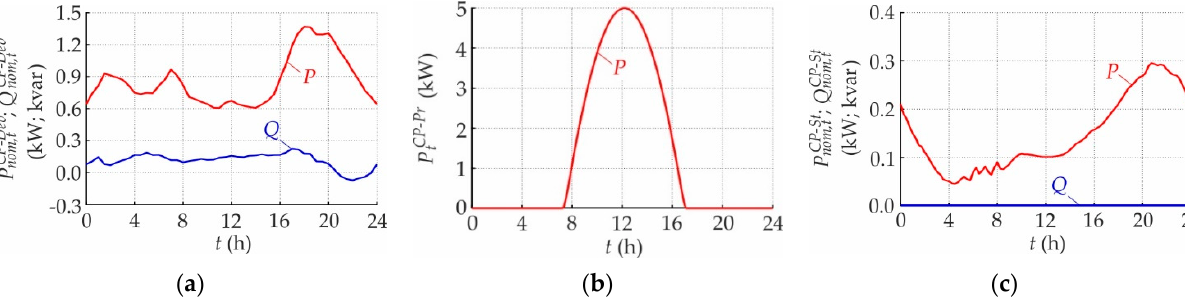
Figure 5. Load and production profiles of different model components of the rural residential CP_Link-Grid: ( a ) Dev.-model; ( b ) Pr.-model; ( c ) St.-model.